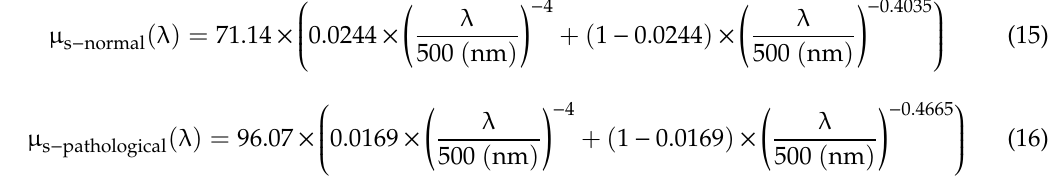
After obtaining the curves for µ g ( λ ). Figure 11 presents the results of these calculations.